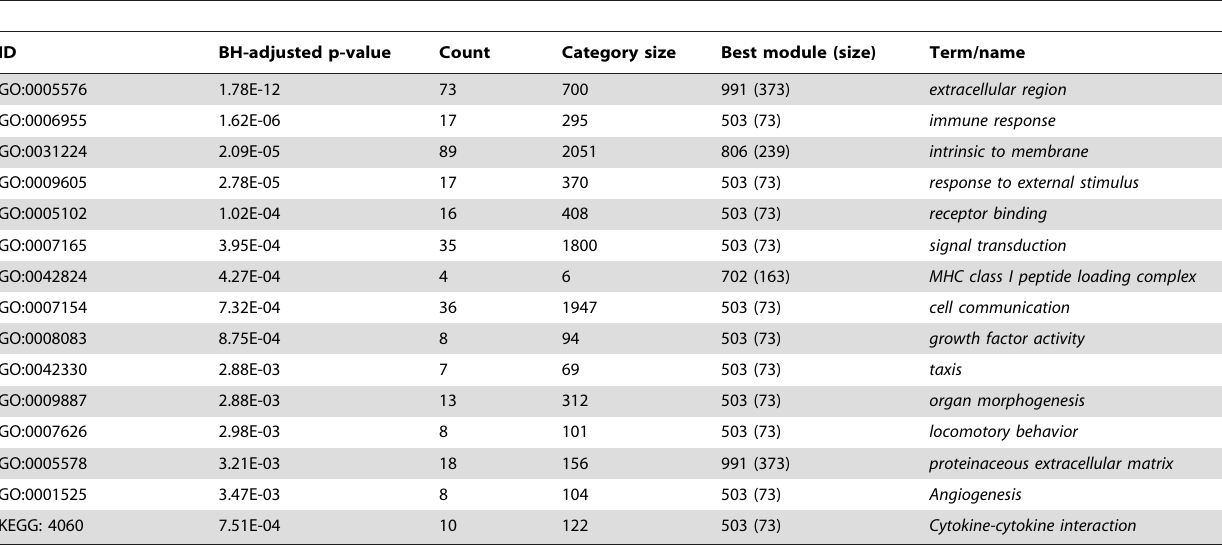
Table 3. Summary of GO terms and KEGG pathways enriched in the dysregulated transcription modules, M2 modular analysis.